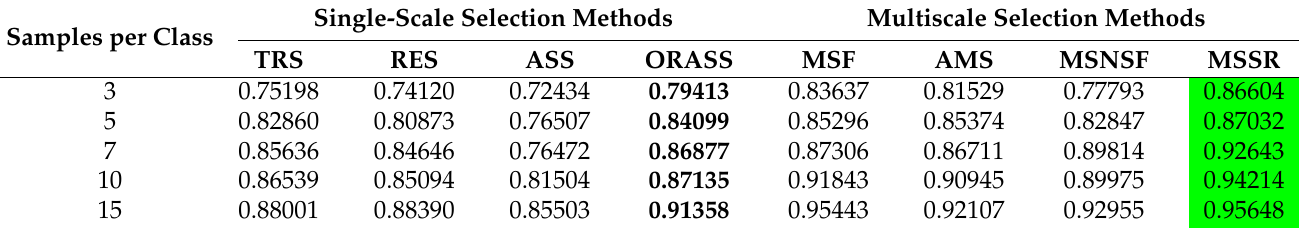
Table 9. OAs obtained by different single scale and multiscale on Indian Pines dataset with different number of training samples per